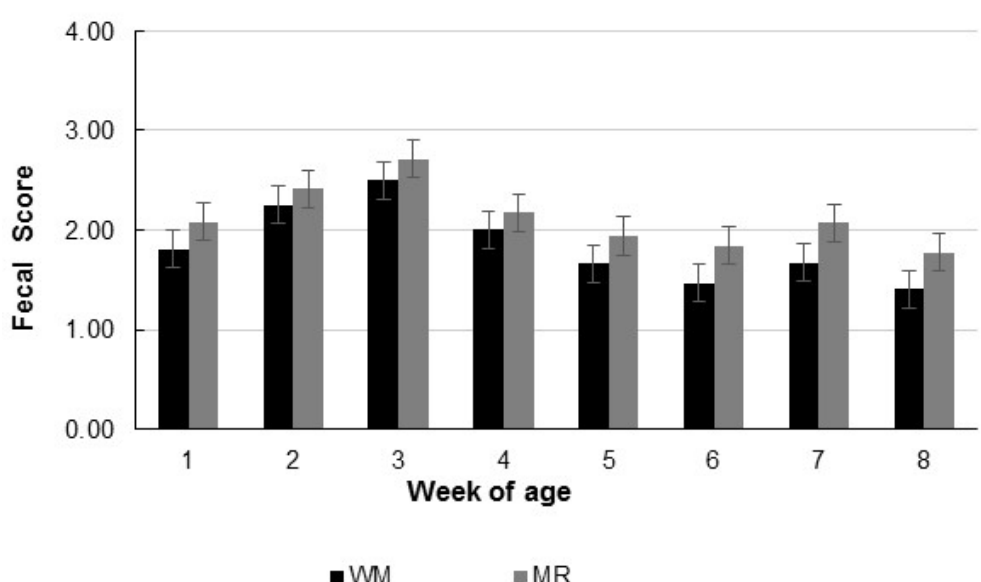
Figure 2. Fecal scores according to the age of calves fed whole milk (WM) or milk replacer (MR) as liquid diet.